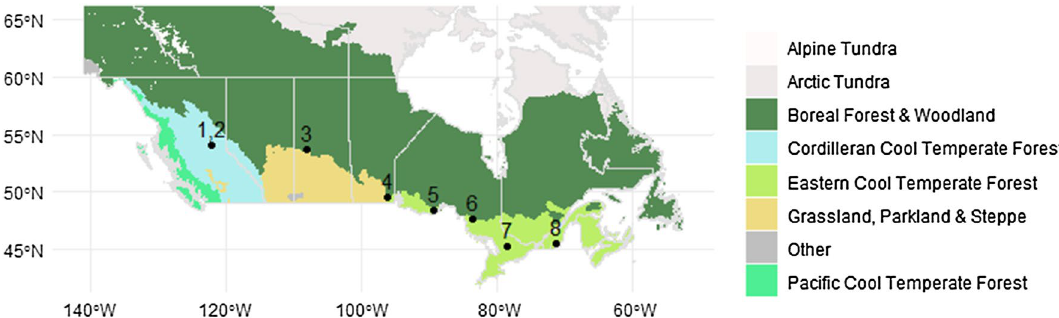
Figure 1. Location of the wood ash study sites across Canada. Site names from left to right include (1) Aleza Lake N, (2) Aleza Lake S, (3) Mistik, (4) Pineland, (5) 25th Sideroad, (6) Island Lake, (7) Haliburton, (8) Eastern Townships Maple. The map is shaded by major forested Vegetation Zones of Canada (https:// open. canada. ca/ data/ en/ datas et/ 22b01 66b- 9db3- 46b7- 9baf- 6584a 3acc7 b1/ resou rce/ 58fdc c95- 5879- 4271- 92aa- 87ca2 8affa 7d) and was constructed in R using ggplot2 with downloaded shapefiles 43,44,46 . Sites used in this study are located on Cordilleran Cool Temperate forest , Boreal Forest , and, Eastern Cool Temperate Forest Centre (Sault Ste. Marie) where soils were homogenized, and subsamples were aseptically taken for enzyme and metabarcoding analyses. One homogenized sample was taken for each treatment at each block of each site. Enzyme analyses. Enzyme analyses were performed for the ecologically important enzymes N-acetylglu- cosaminidase (NAG) and phosphatase (PHOS). All enzyme activities were performed in 96-well plates under controlled conditions using 4-methylumbelliferone-fluorescence tagged substrates (pH 5 and room tempera- ture) and measured with a BioTek Synergy H1 Hybrid spectrophotometer/fluorometer. Incubation times were based on time-trials conducted on a subset of samples. Samples were stored at – 20 °C prior to analysis via exist- ing protocols 33,34 . Metabarcoding. DNA extractions were performed on homogenized bulk soil samples using Qiagen DNEasy Powersoil extraction kits. Extracted DNA was then amplified using primers targeted for specific groups